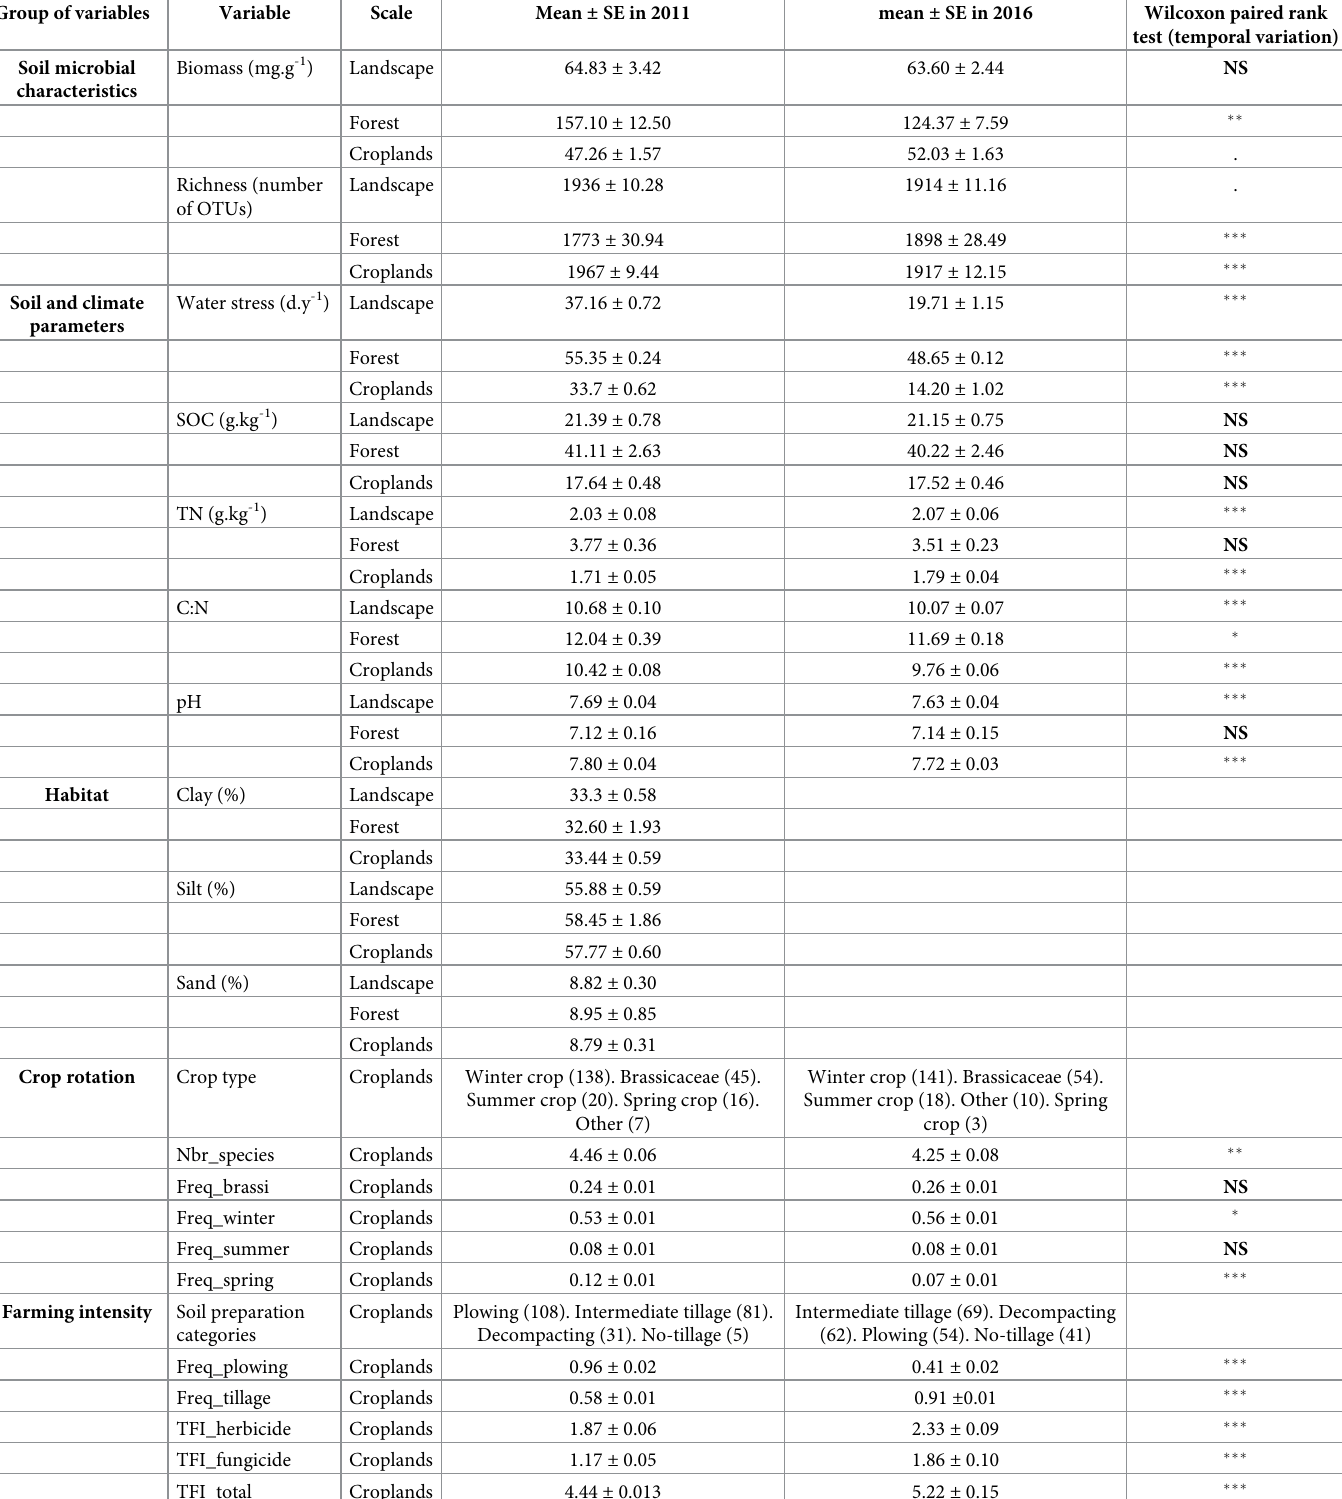
Table 1. Summary of the statistics of microbial variables, soil parameters and farming